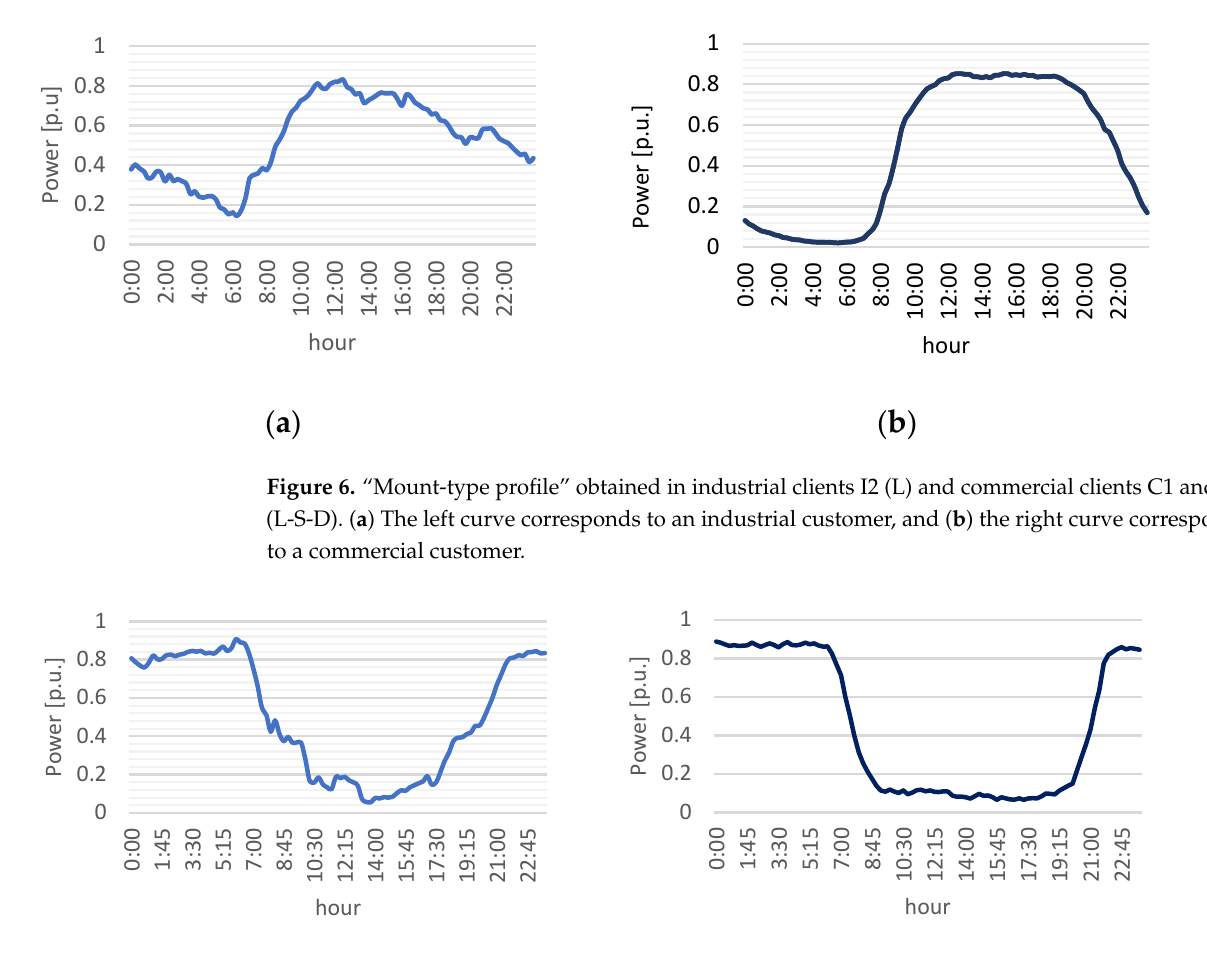
Figure 5. “M-type profile” obtained in industrial clients I1 and I2 (L) and commercial clients C1 and C2 (L). ( a ) The left curve corresponds to an industrial customer, and ( b ) the right curve corresponds to a commercial customer.